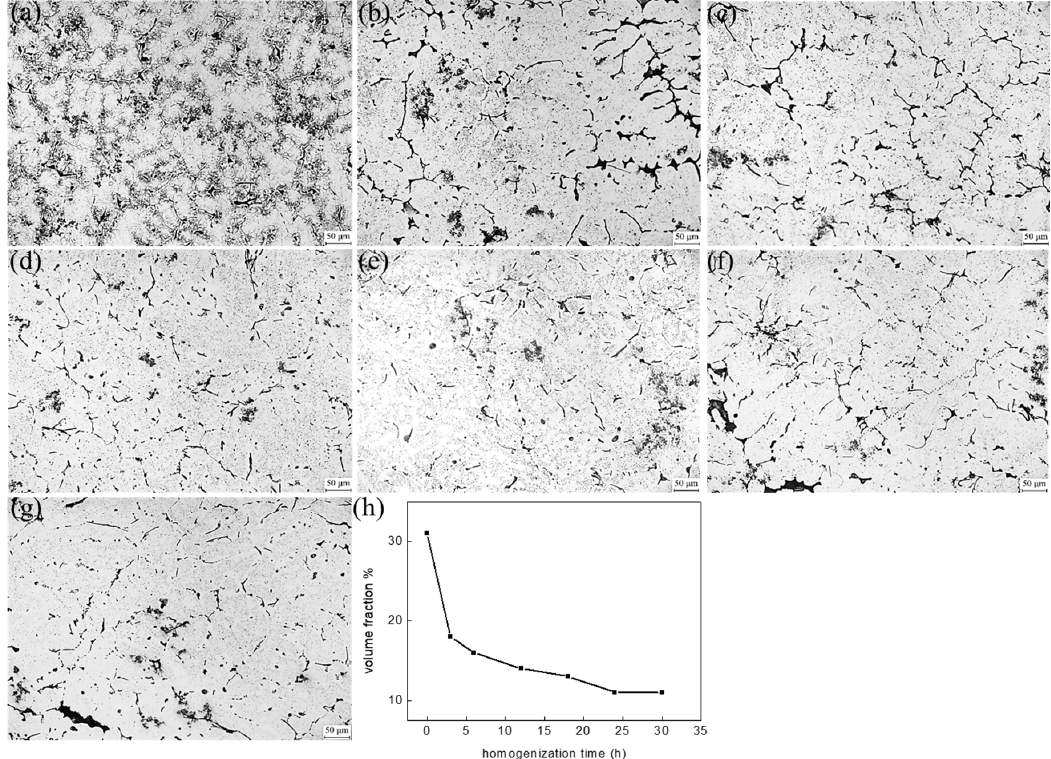
Figure 4. Optical microstructure depending on the homogenization time (×100): ( a ) no homogenization, ( b ) 3 h, ( c ) 6 h, ( d ) 12 h, ( e ) 18 h, ( f ) 24 h, and ( g ) 30 h at 450 °C ; ( h ) volume fraction of grain boundary calculated by Image pro 5.0.